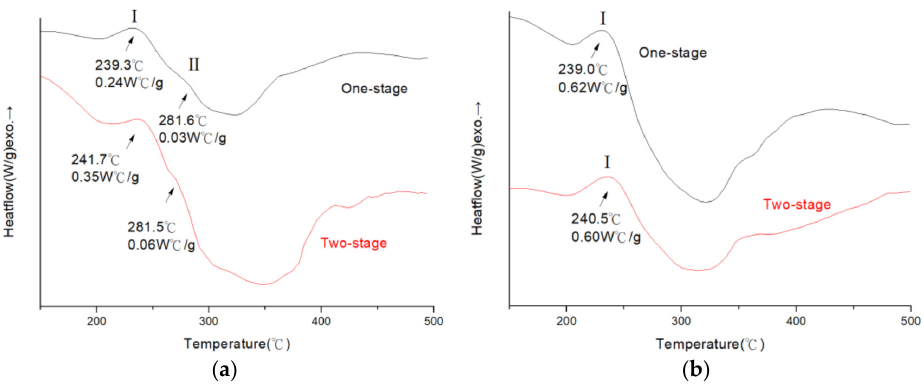
Figure 8. The DSC curve analysis after solution treatment of ( a ) alloy A(0.1Zr); ( b ) alloy B(0.05Sc).